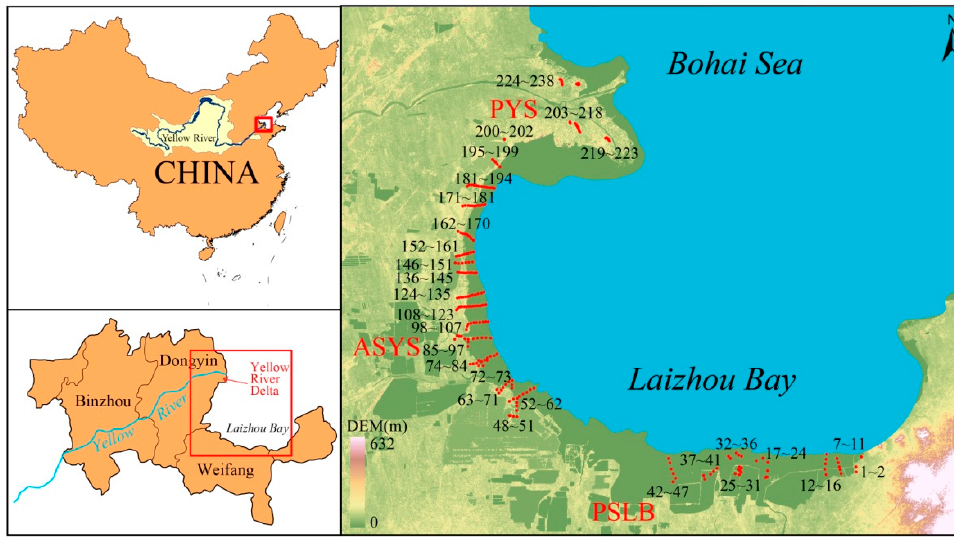
Figure 2. Sample locations along the southwestern coast of Laizhou Bay, China.